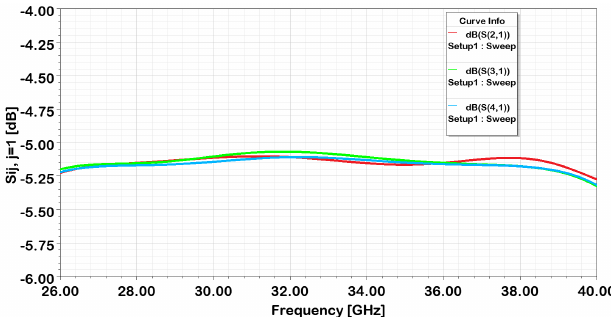
FIGURE 15. Insertion Losses of the system with a triple P-QWT.